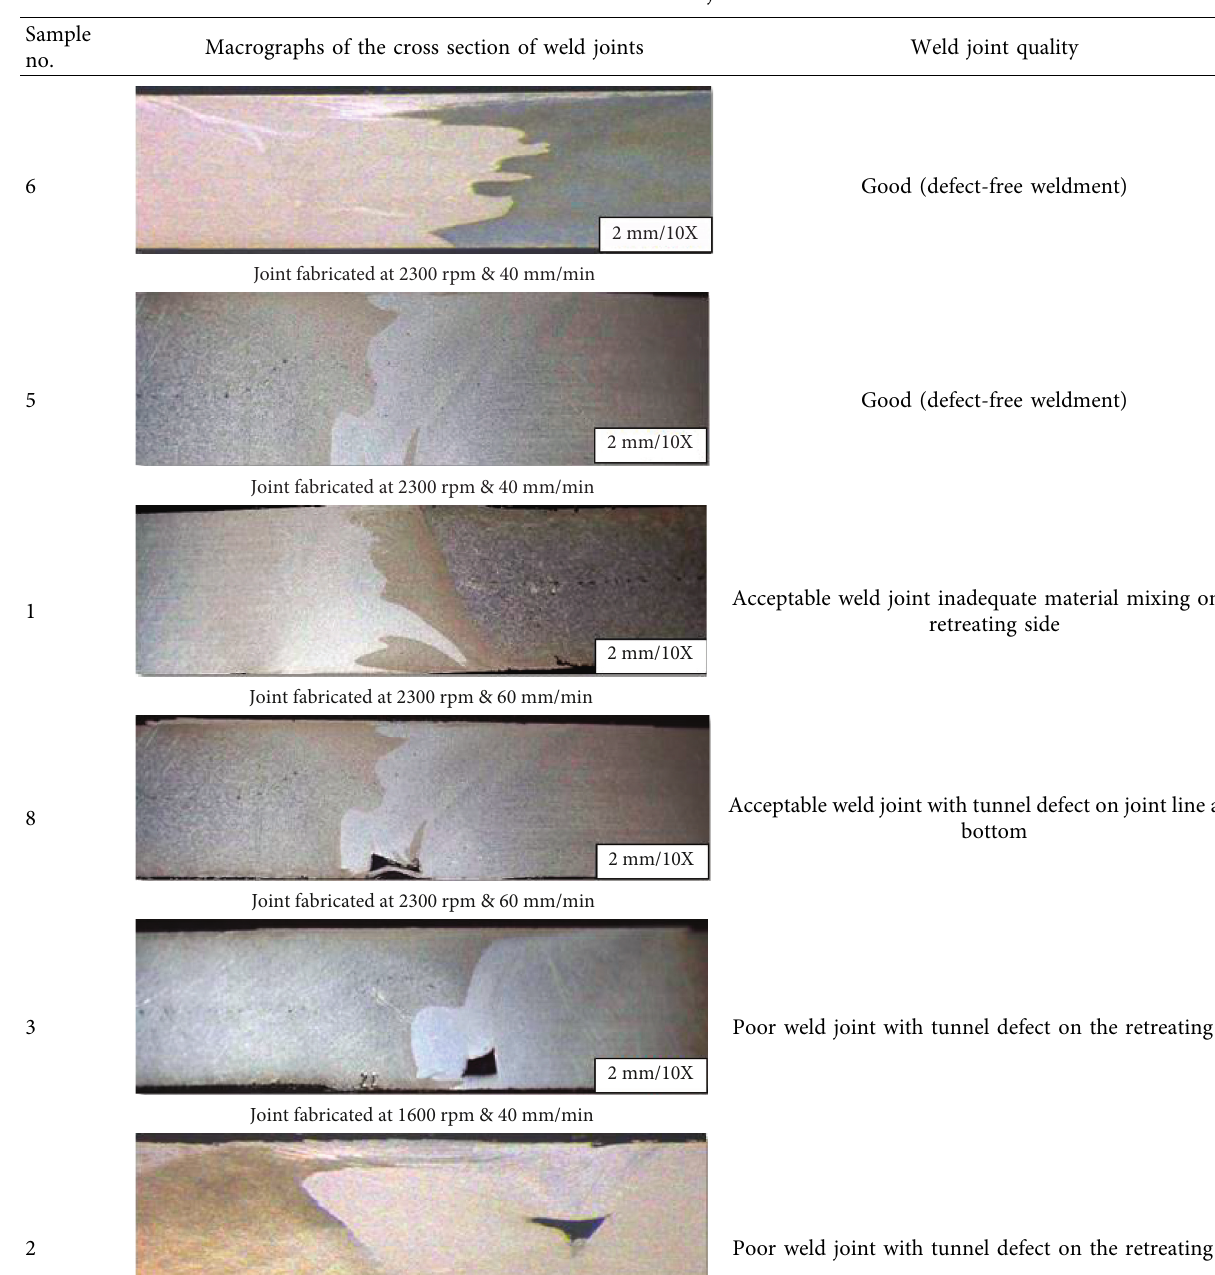
Table 8: Macrostructures of weld joints cross